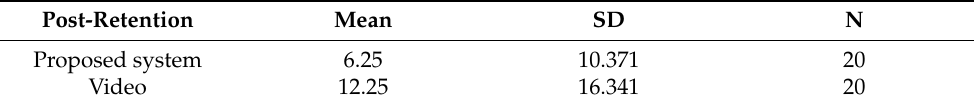
Table 3. Post-test and retention-test average score difference for each group.